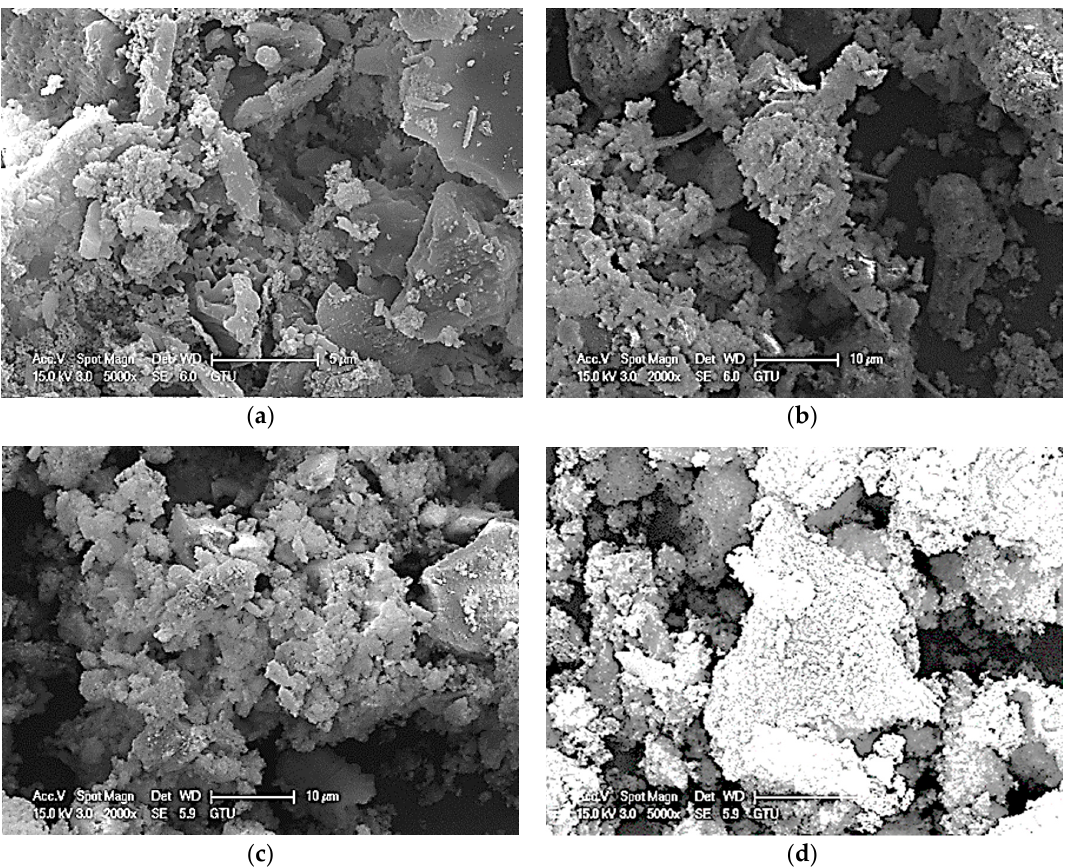
Figure 3. Scanning electron microscope (SEM) images of model adhesives used in Phase 1 study. ( a ) P1AD1 (5000×); ( b ) P1AD2 (2000×); ( c ) P1AD3 (2000×); ( d ) P1AD4 (5000×).